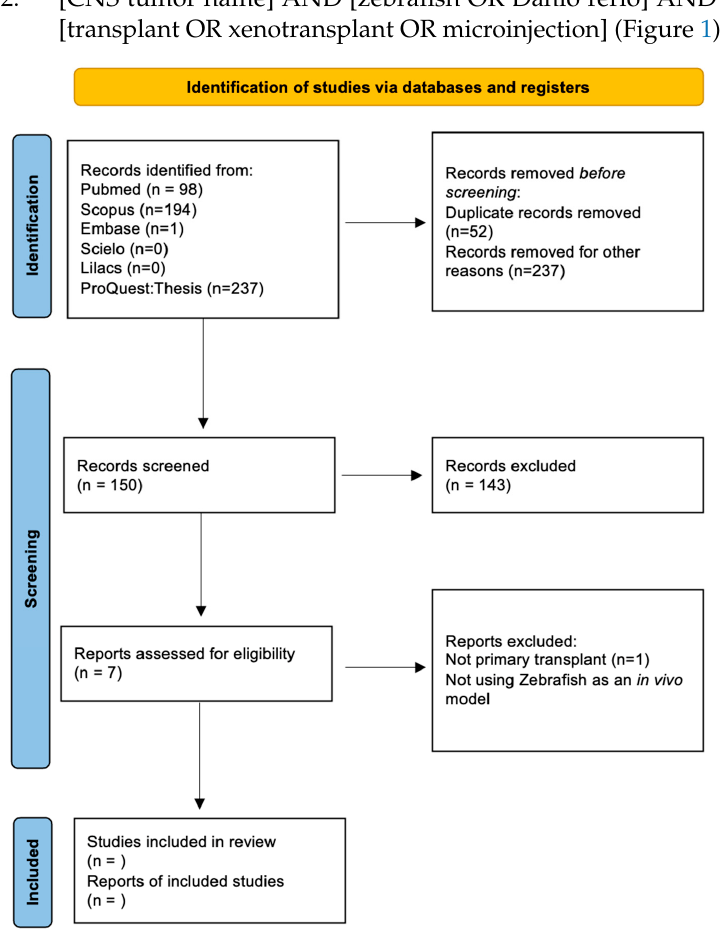
Figure 1. Scheme showing the systematic review process based on the PRISMA 2020 statement [85].